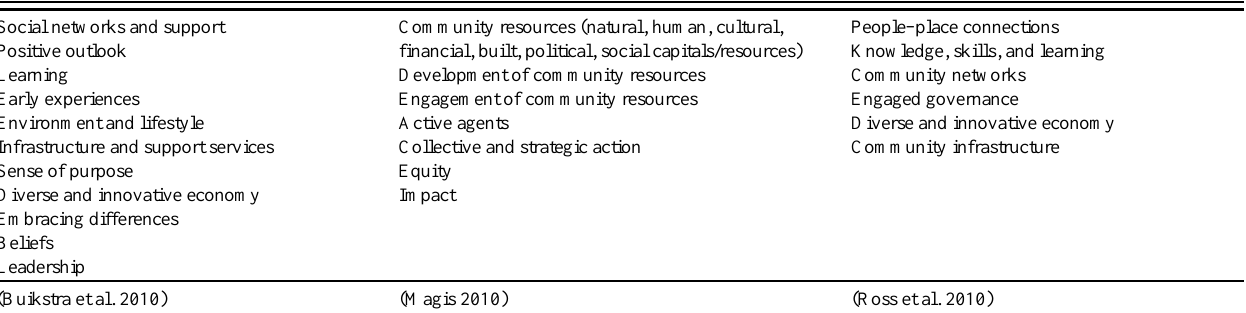
Table 1 . Three approaches showing factors important for community